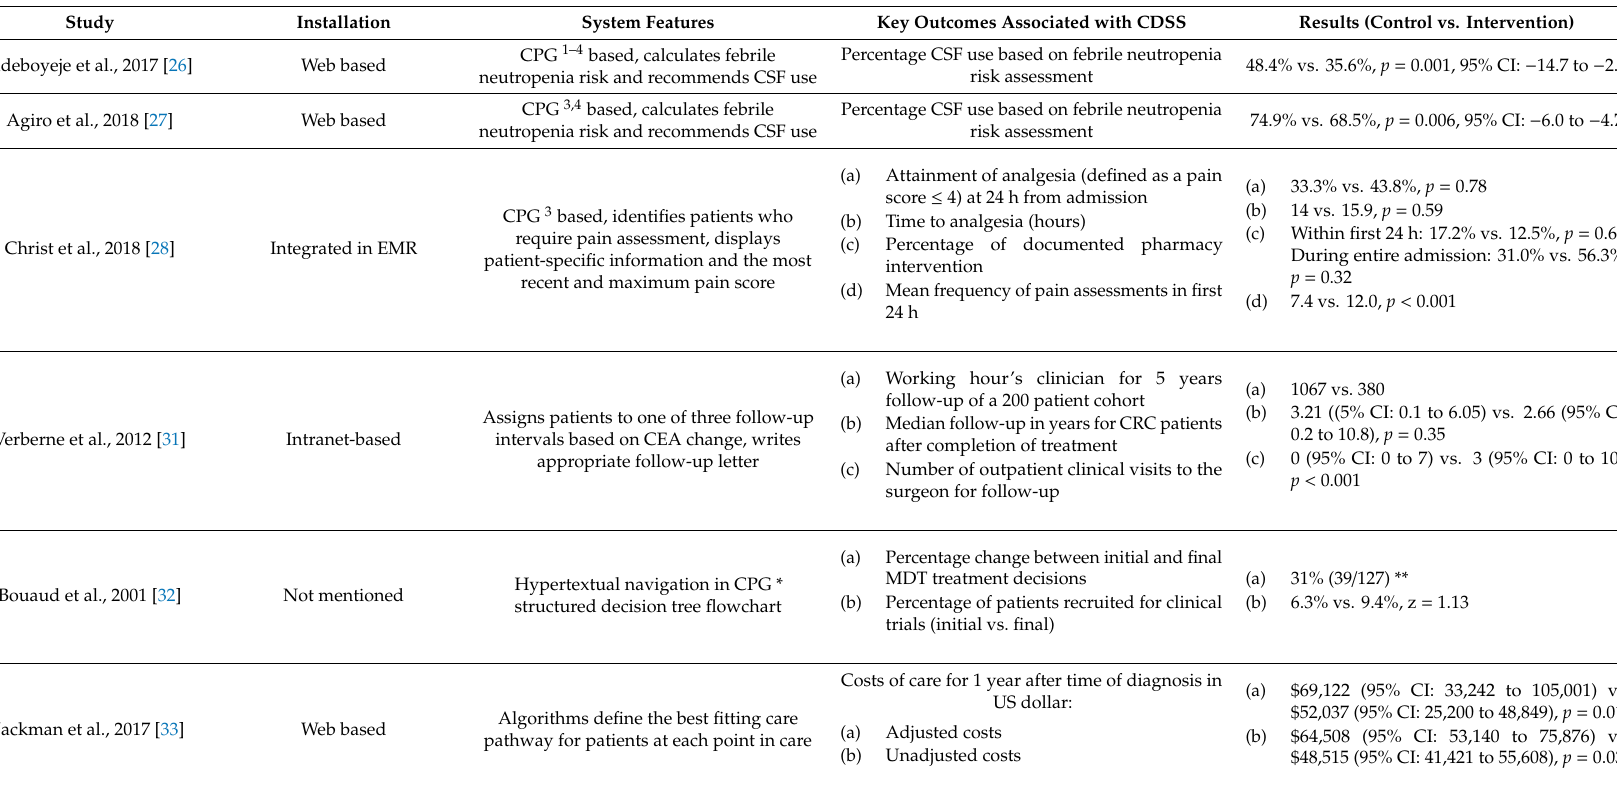
Table 2. Impact of CDSS on Process